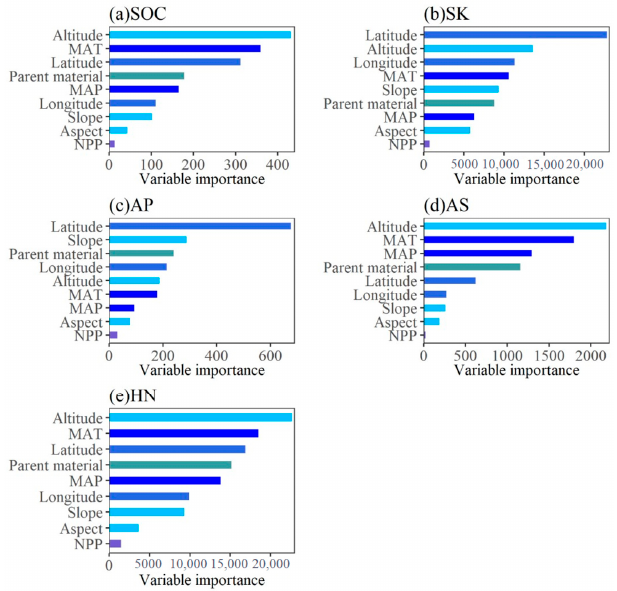
Figure 3. Variable importance of predictors in forecasting soil physicochemical properties. (MAT indicates mean annual temperature, MAP indicates mean annual precipitation, NPP indicates net primary productivity). ( a ) SOC indicates soil organic carbon concentration; ( b ) SK indicates soil available potassium concentration; ( c ) AP indicates soil available phosphorus concentration; ( d ) AS indicates available sulfur concentration; ( e ) HN indicates soil hydrolyzed nitrogen concentration.